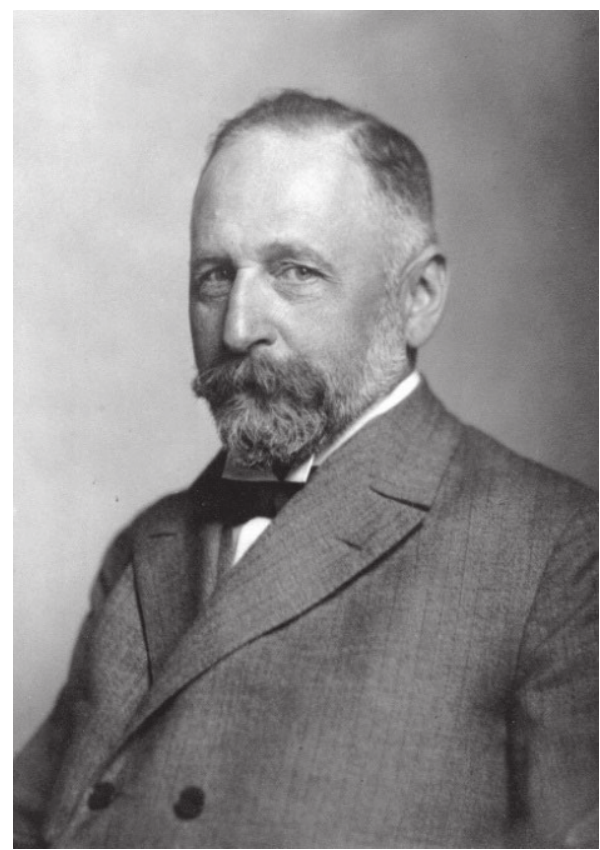
Figure 6. Richard Willstätter (1872-1942) (Edgar Fahs Smith Memorial Collection. Kislak Center for Special Collections, Rare Books and Manuscripts. University of